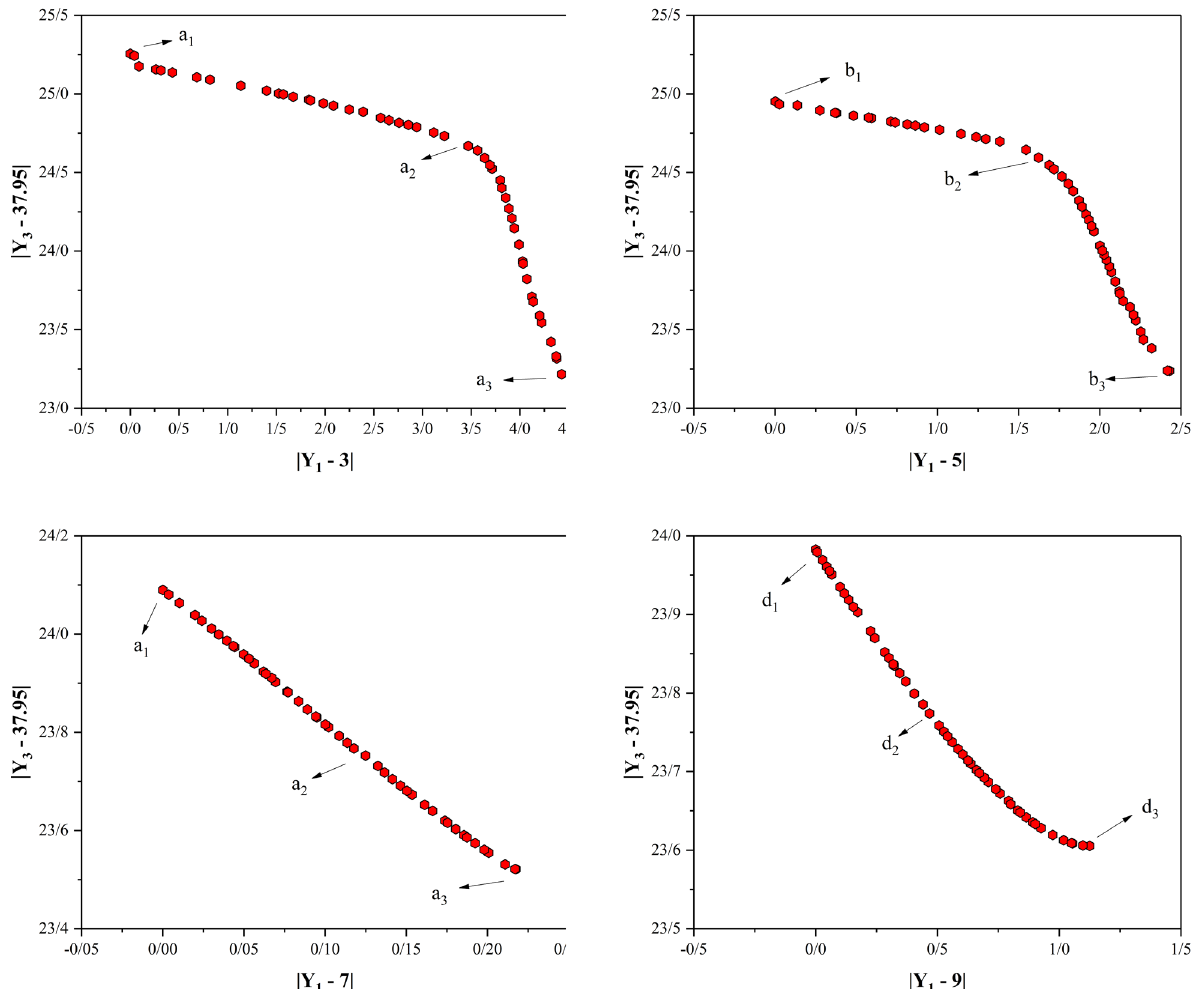
Figure 11: Pareto optimal front for obtaining L* (Y3) equal to 37.95 and different amounts (3, 5, 7, and 9 μm) of PS (Y1) (specified points are introduced in supporting